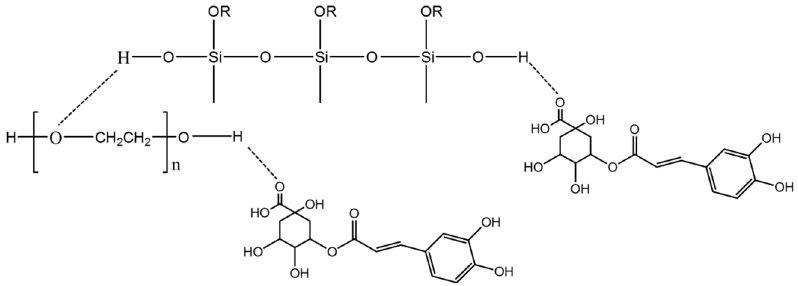
Figure 3. A graphical representation of the hybrids.